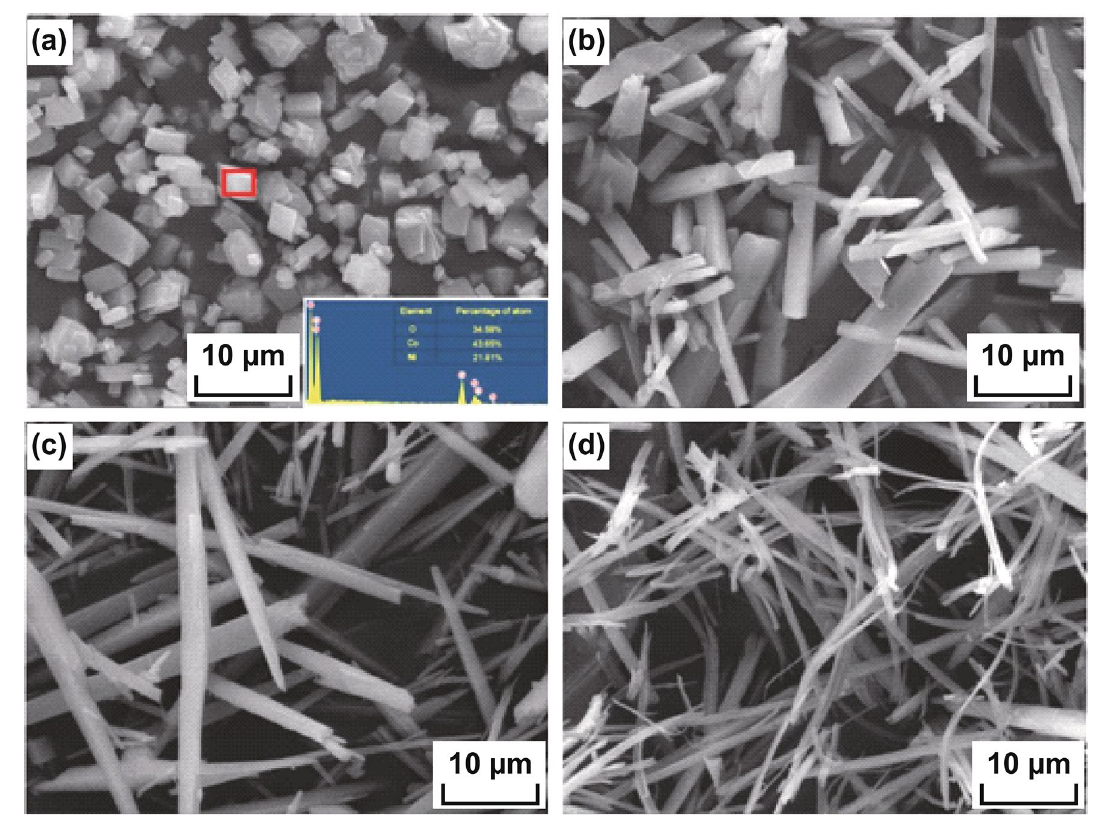
Fig. 14 FESEM images NiCo 2 O 4 precursor powders prepared at a pH = 3, b pH = 7, c pH = 8 and d pH = 8.4. Reproduced with permission from Ref. [159]. Copyright © 2018 Elsevier